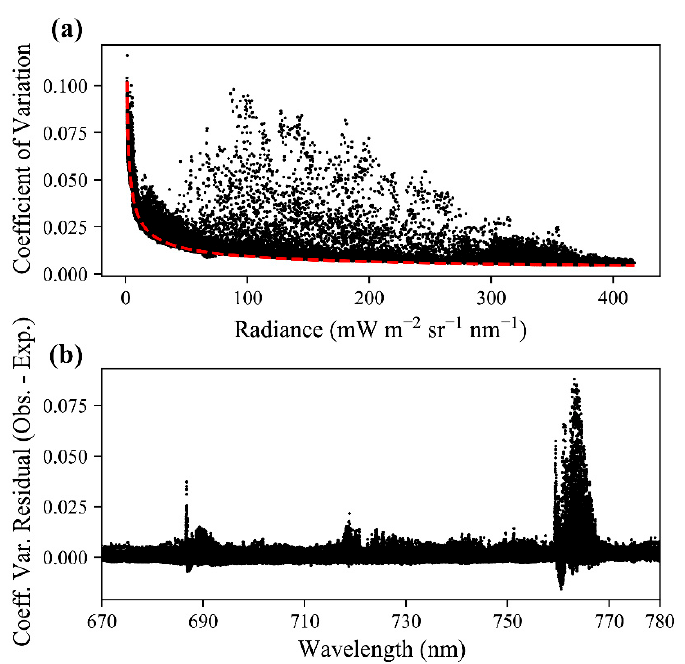
Figure 12. ( a ) The coefficient of variation of FIREFLY radiance in spatial pixel 133, all bands, all targets over thousands of consecutive samples (black dots), compared to the expected coefficient of variation based on the noise characterization with the integrating sphere (red dashed line). ( b ) The residual of the coefficient of variation (observed–expected) (black dots) based on the samples in (a).